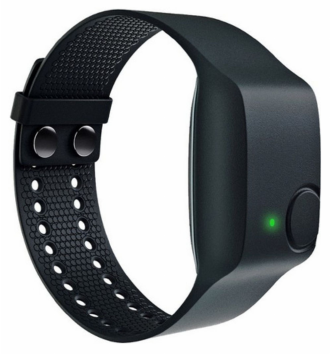
Figure 2. Empatica E4